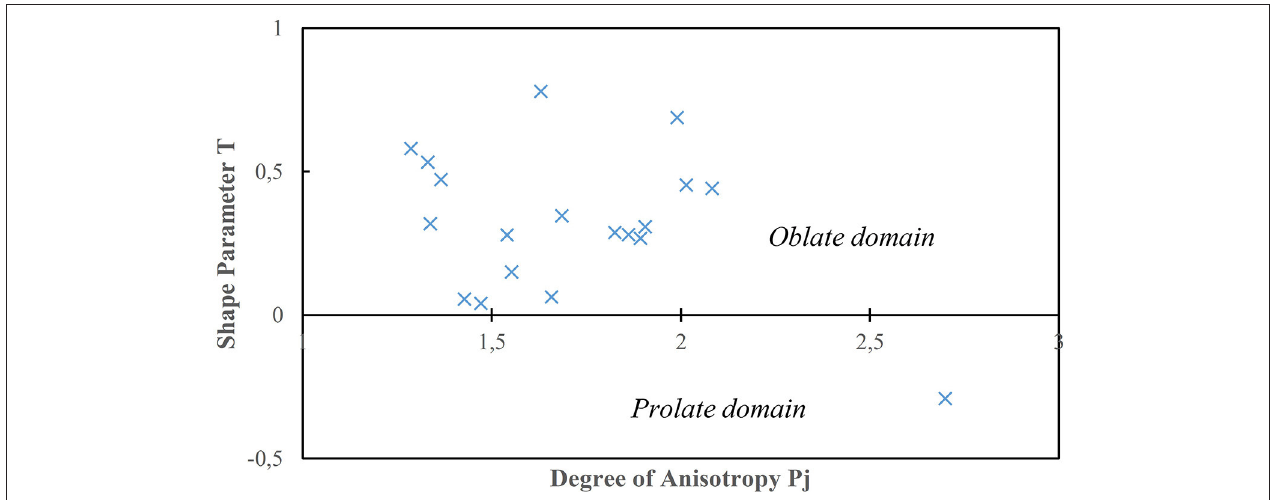
FIGURE 6 | Jelinek plot showing the relationship between the shape parameter and degree of anisotropy. Each point corresponds to one of the core fragments selected for magnetic mineralogy measurements. The shape parameter reflects the overall aspect of the ellipsoid, while the degree of anisotropy approximately translates the difference between its largest and smallest dimensions.